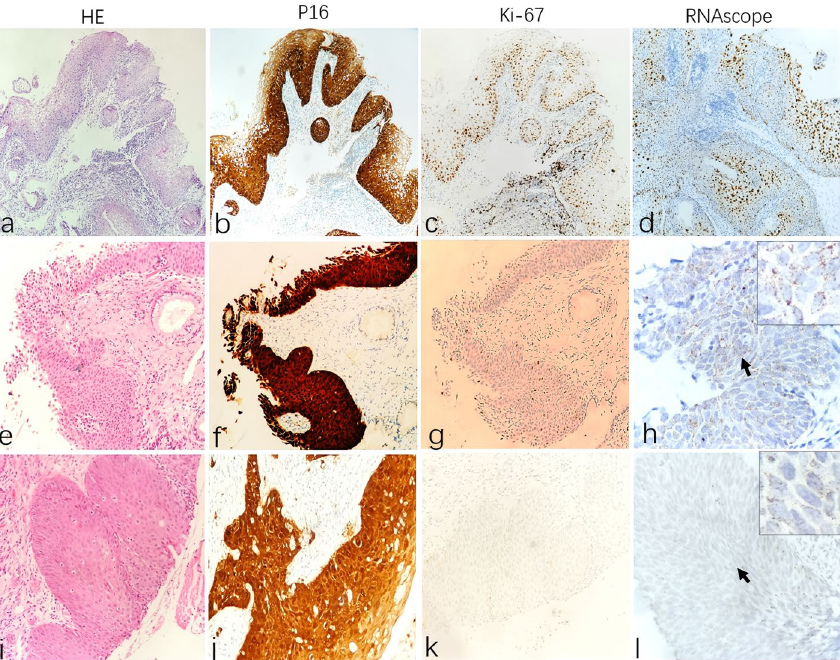
Fig. 3 The H&E morphology, P16/Ki67 phenotype and RNAscope expression patterns in Test-B group. Row1 ( a - d ): In CIN1 case with low expression of Ki67, RNAscope show diffuse clustered expression pattern in nuclei/cytoplasmic, and the staining areas is mainly located on the surface epithelium ( d ). Row2 ( e – h ): In case originally diagnosed as CIN2 with low expression of Ki67, RNAscope show dotted full-thickness nucleus/ cytoplasmic scattered staining ( h , arrow). Row3 ( i - l ): In CIN3 cases with low expression of Ki67, RNAscope show dotted full-thickness nucleus/ cytoplasmic scattered staining ( l ,